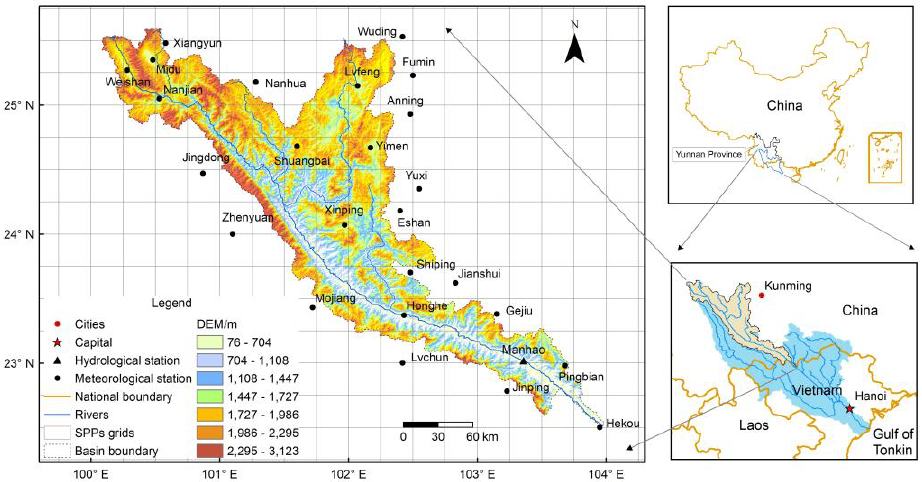
Figure 1. Location of the upper catchment of the Red River Basin (URRB) and distribution of meteorological and hydrological